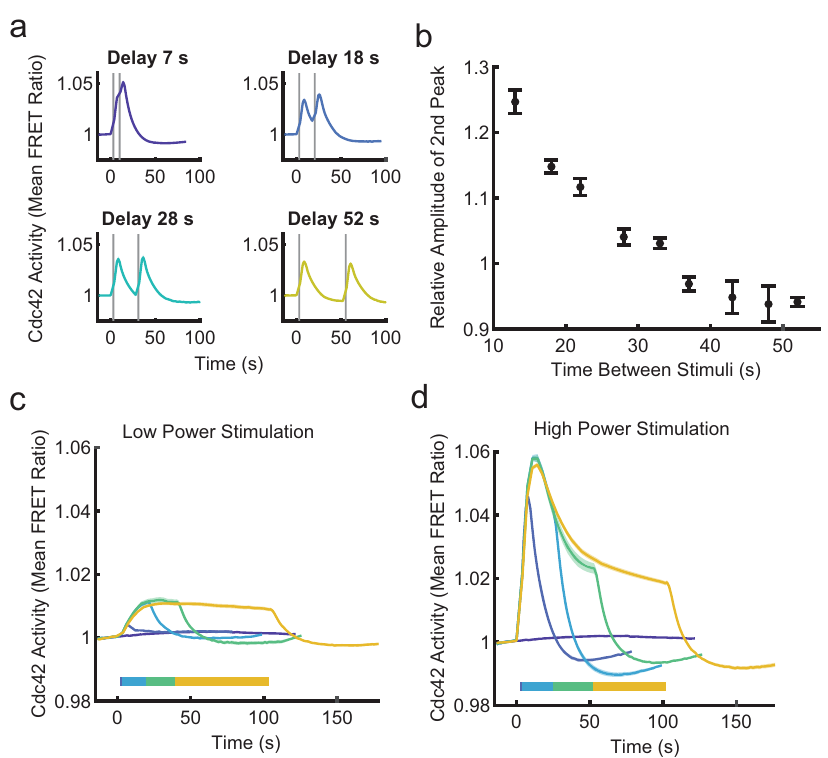
Fig. 3 The Cdc42 circuit is regulated by complex, multi-level negative regulation. a Cdc42 responses are shown for four different two-pulse stimulation protocols with the indicated delay times between stimulations. The relative light intensity was ten for all plots. Data are presented as mean ( n well = 30 for 7s, n = 6 for 18s, n = 6 for 28s, and n = 4 for 52s). See Supplementary Fig. 2 for all two-pulse stimulation well replicates well replicates well replicates replicates plots. Stimulus duration indicated by gray bars. b Relative amplitude of the second Cdc42 response peak as a function of time between stimuli. The relative amplitude is calculated as the ratio of the second peak to the fi rst peak. A time delay of 7 s was not included because a second peak could not be resolved from the fi rst. Data are presented as mean± s.e.m. ( n well replicates = 6 for 13s, n well replicates = 6 for 18s, n well replicates = 6 for 22s, n well replicates = 6 for 28s, n = 26 for 33 s, n = 4 for 37s, n = 4 for 43s, n = 4 for 48s, and n = 4 for 52s). c , d Repeated global well replicates well replicates well replicates well replicates well replicates stimulations were applied to simulate continuous receptor stimulation. Stimulation duration is indicated by horizontal color bars. Data are presented as mean± s.e.m. c Cdc42 response to the indicated stimulus durations with low-power stimulation (relative light intensity = 1). n well replicates = 65 for non- stimulated, n well replicates = 21 for 1 stimulation, n well replicates = 20 for 7 stimulations, n well replicates = 21 for 15 stimulations, and n well replicates = 27 for 30 stimulations. d Cdc42 response to the indicated stimulus durations with high-power stimulation (relative light intensity = 100). n well replicates = 65 for 0 stimulation condition, n well replicates = 12 for 1 stimulation, n well replicates = 12 for 7 stimulations, n well replicates = 12 for 15 stimulations, and n well replicates = 77 for 30 stimulations. Source data are provided as a Source Data fi